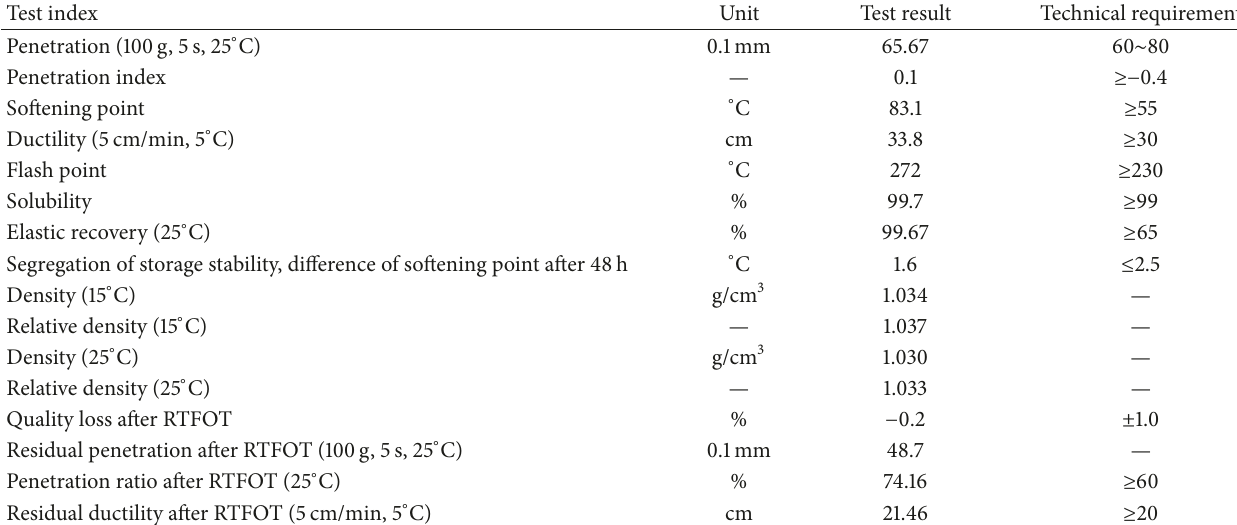
Table 2: Technical properties of SBS modified